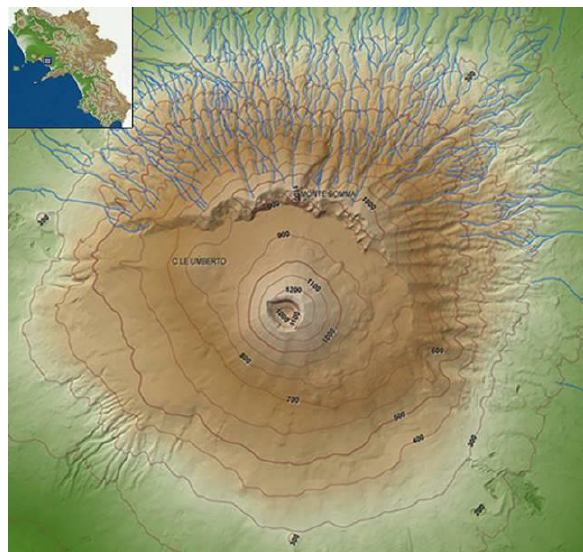
Figure 16. Hydrography of Mount Vesuvius (from: Geological Service and Soil Defence - Campania Region).